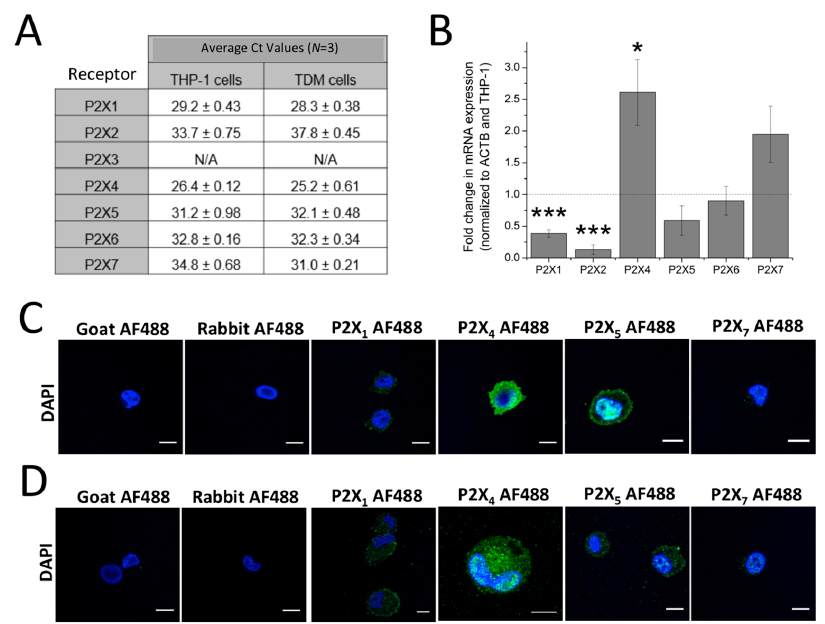
Figure 1. Expression of P2X receptors in THP-1 monocytes and THP-1-differentiated macrophages. ( A ) table showing qRT-PCR Ct values to identify which P2X genes are expressed in THP-1 cells and THP-1 differentiated macrophages. Ct values above 35.0 were considered absent ( n = 3). Undetected genes are represented as N/A; ( B ) fold change in mRNA expression of P2X receptor genes in THP-1 differentiated macrophages, normalized to β -actin and THP-cells ( n = 3). Asterisks include significant changes towards control (*** p < 0.001, * p < 0.05); ( C , D ) immunocytochemistry of P2X receptor expression in THP-1 monocytes and THP-1 differentiated macrophages, respectively, as observed under confocal microscopy. Blue represents 2-4(amidinophenyl)-1 H -indole-6-carboxamidine (DAPI) nuclear stain while green represents human P2X receptor conjugated with AF488. Scale bar represents 10 μ m. Images are representative of n = 3 replicates. TDM: THP-1 differentiated macrophages.